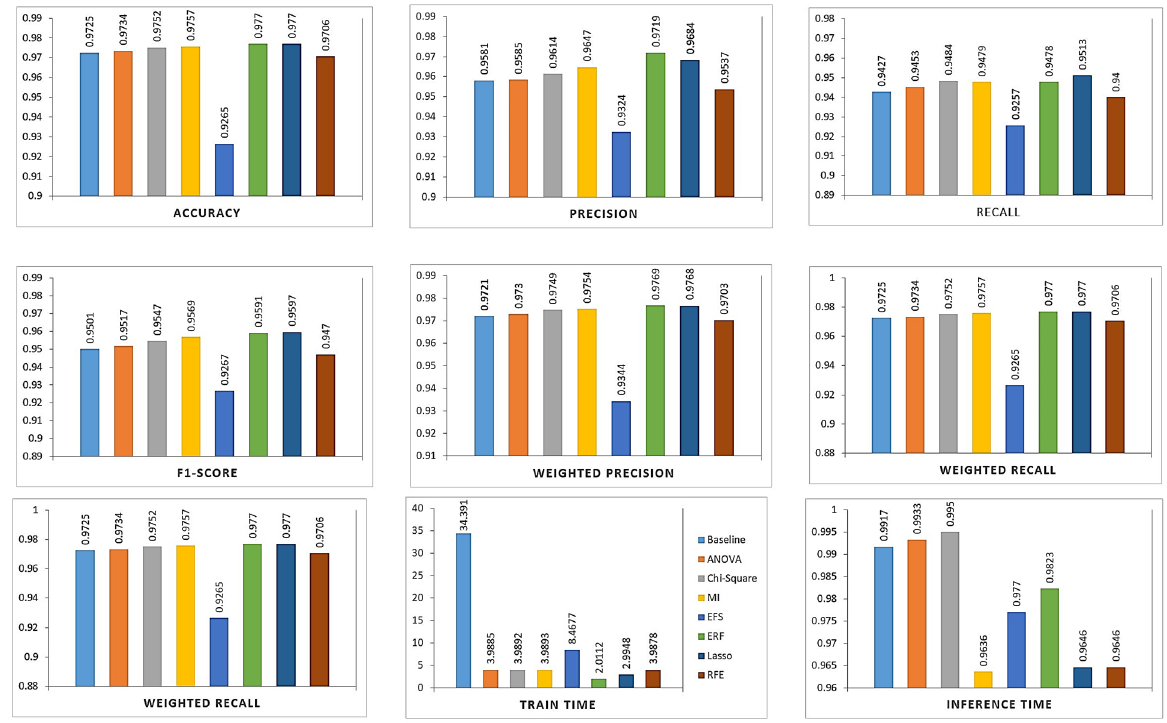
Figure 3. Performance comparison of feature selection methods.